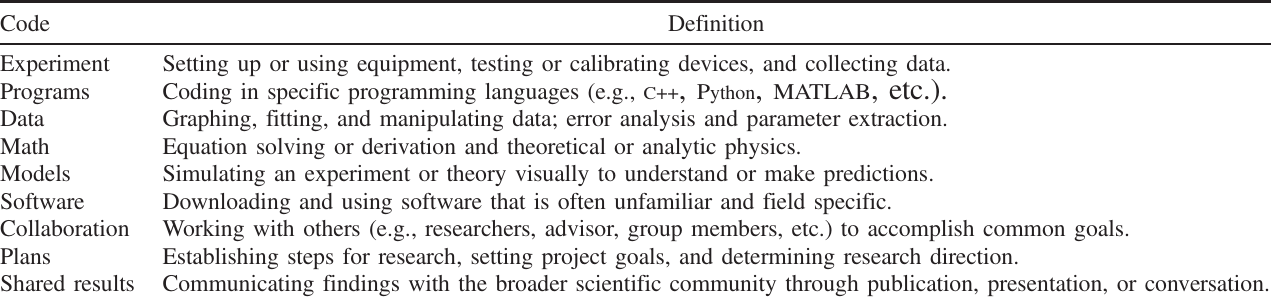
TABLE I. Problem context.